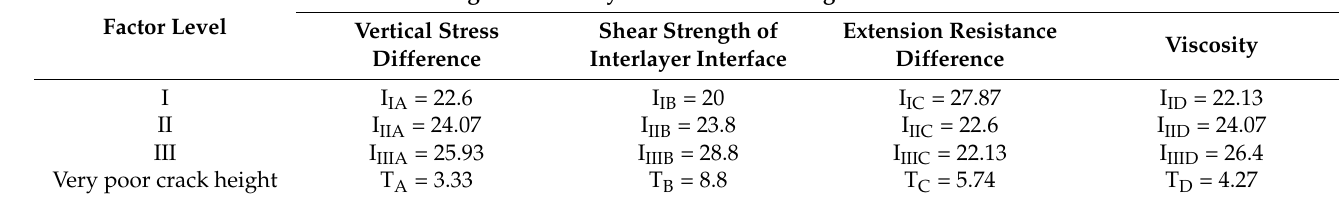
Table 5. Analysis table of orthogonal test results.